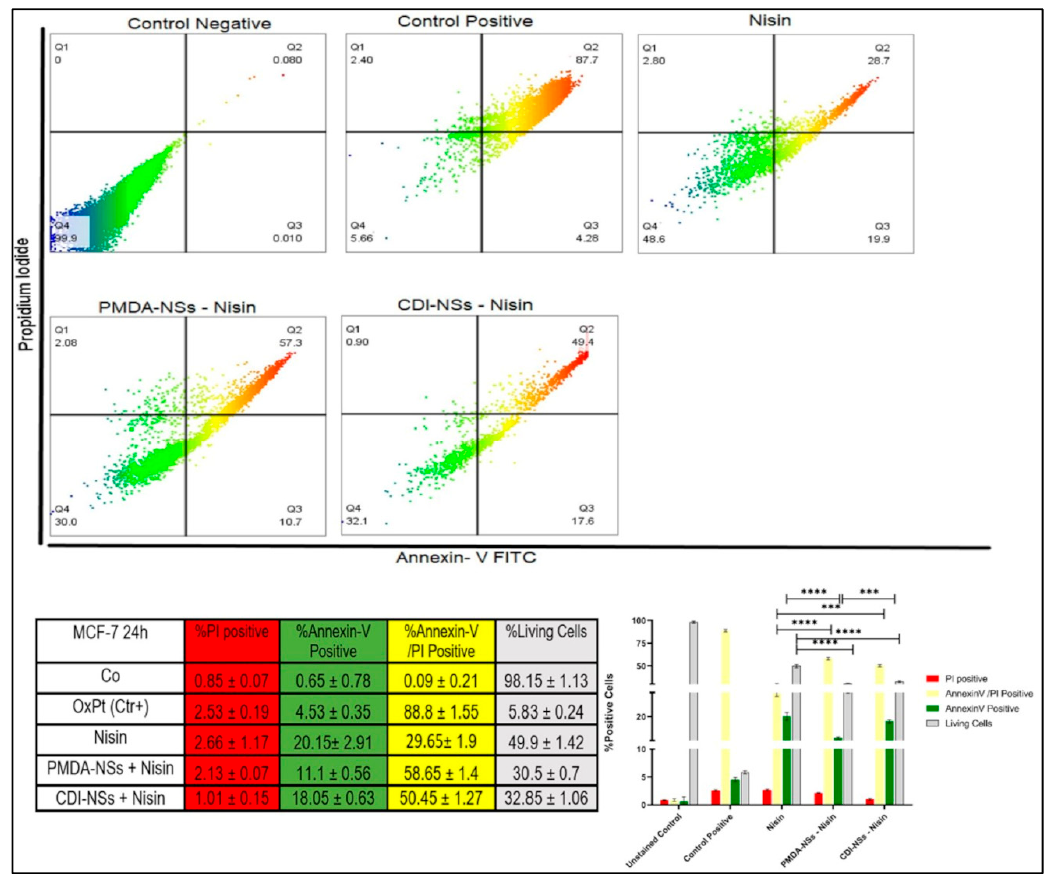
Figure 8. Representative flow cytometric dot-plots indicating the population sizes of apoptotic and necrotic in MCF-7 cells after exposure to 250 µg/mL of Nisin Z and loaded on PMDA/CDI-NSs for 24 h. Analyses were performed with annexin-V-FITC (FITC) and propidium iodide (PI). The untreated control was not exposed to Nisin Z and the complexes, and positive control was treated with oxaliplatin (OxPt). Experiments were done in triplicate and independently repeated. Bar graphs illustrate the percentage of apoptotic, necrotic, and late-stage apoptotic MCF-7 cells after exposure to free Nisin Z and encapsulated by the NSs. *** p < 0.001, **** p < 0.0001 apoptosis relative to the free Nisin Z. Data are expressed as mean ± SD ( n = 3). Two-way ANOVA analyses was